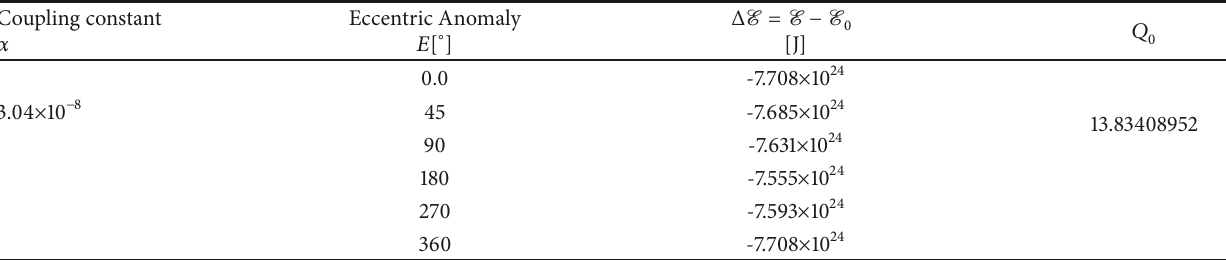
Table 2: Tabulation of parameters Δ E = E − E 0 and 𝑄 0 relating to the mediating graviton mass at perihelion for a sun like star as is “felt” by the secondary i.e. Mercury for 𝛼 = 3.04 × 10 −8 and 𝜆 = 4.937 × 10 15 m, e= 0.205.